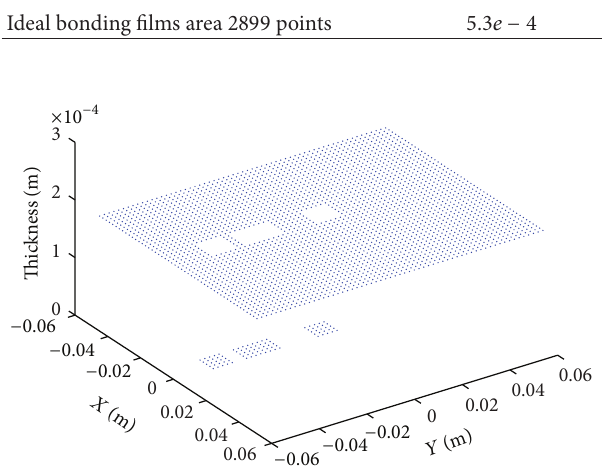
Figure 8: Inversed results of the thicknesses of the bonding films and